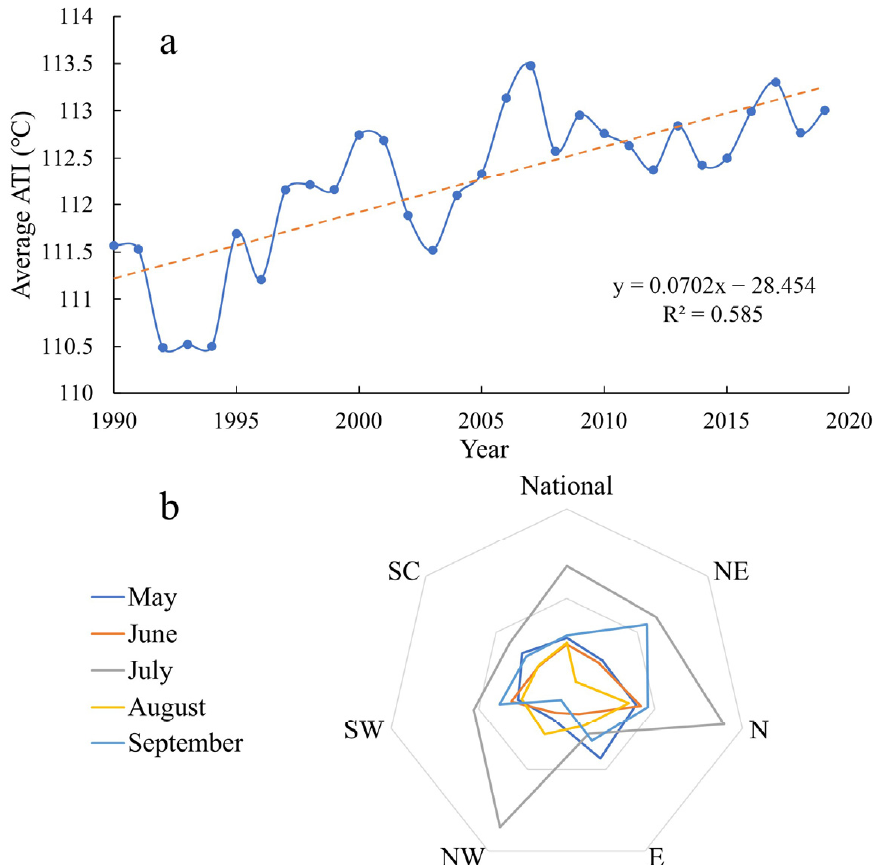
Figure 5. Annual changes in the national ATI in 1990 − 2019 ( a ) and the RC values of the ATI between 1990–1994 and 2015–2019 ( b ).